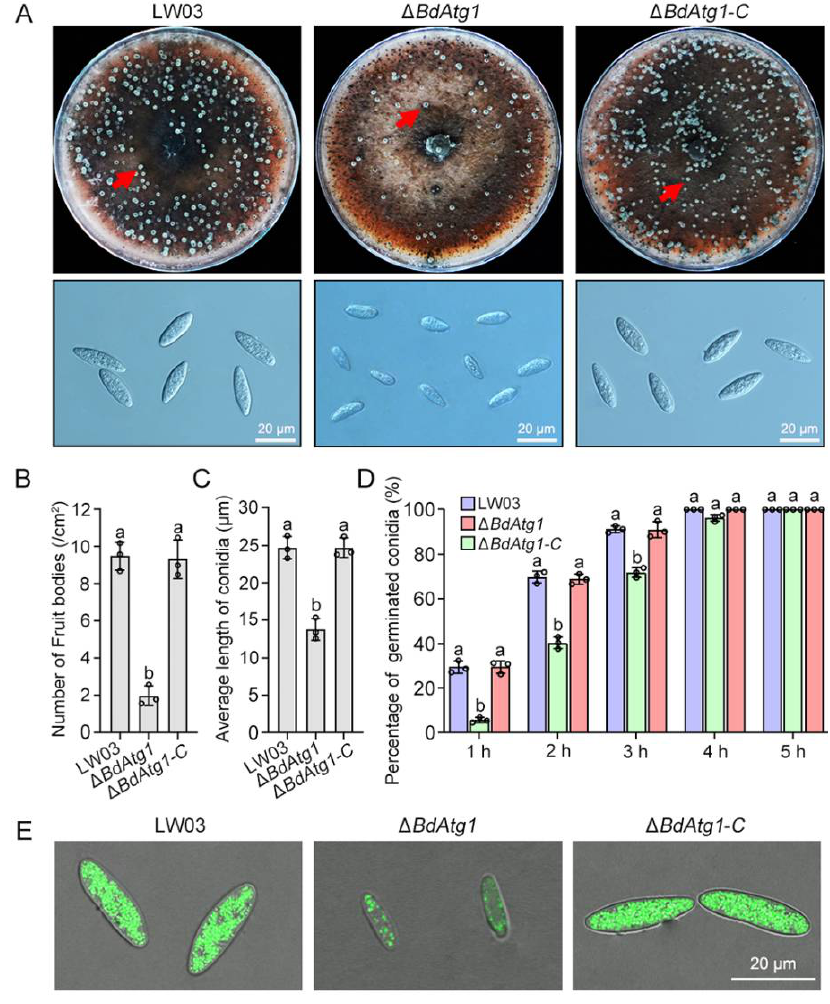
Figure 4. BdAtg1 is crucial for conidiation. ( A ) Fruiting bodies formed on carrot agar medium by B. dothidea strains (upper panel), and conidial morphology of each strain (bottom panel). The red arrows in indicate fruiting bodies. ( B ) Number of fruiting bodies formed by each strain. ( C ) Average length of conidia of each strain. ( D ) Conidia germination rete of each strain. Error bars indicate standard deviation from three independent experiments. Values on the bars followed by the same letter are not significantly different at p = 0.05. ( E ) Lipid droplets within conidia of each strain.